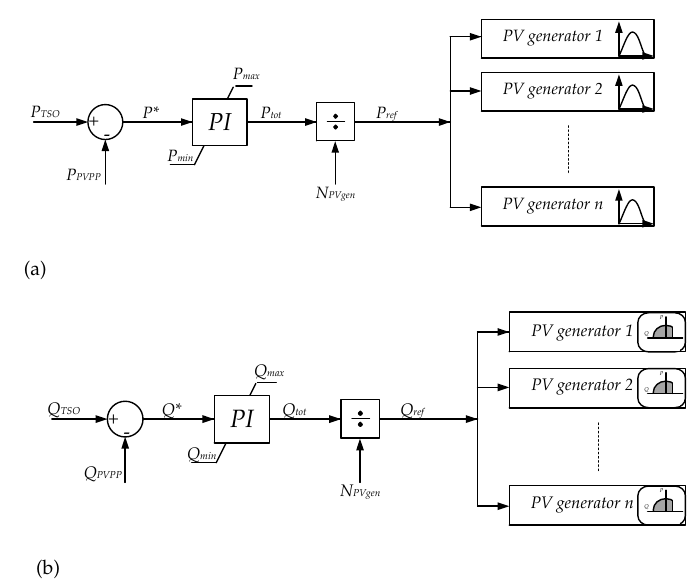
Figure 5. Power plant control ( a ) Active power and ( b ) Reactive power.